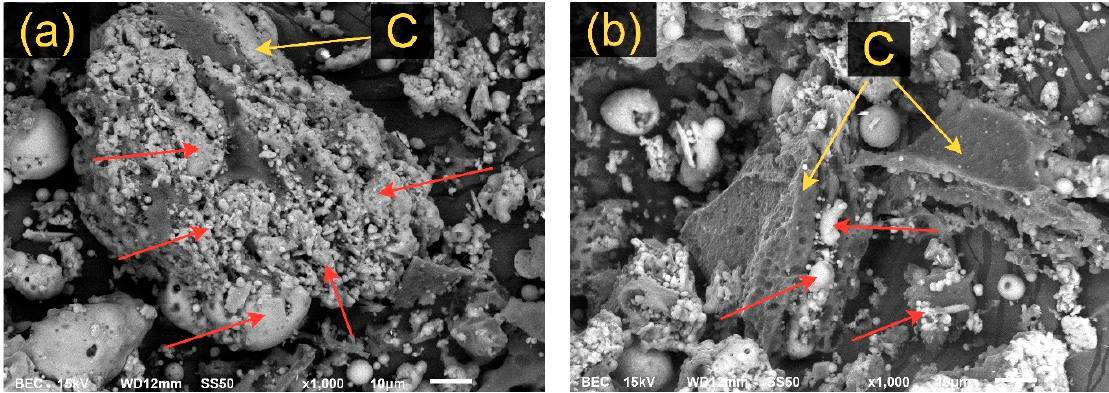
Figure 10. The SEM images of unburned carbon particles obtained by flotation kinetics tests: ( a ) particle size of 71–100 µ m; ( b ) particle size of 40–71 µ m (yellow arrows show unburned carbon particles; red arrows show alumosilicates particles).